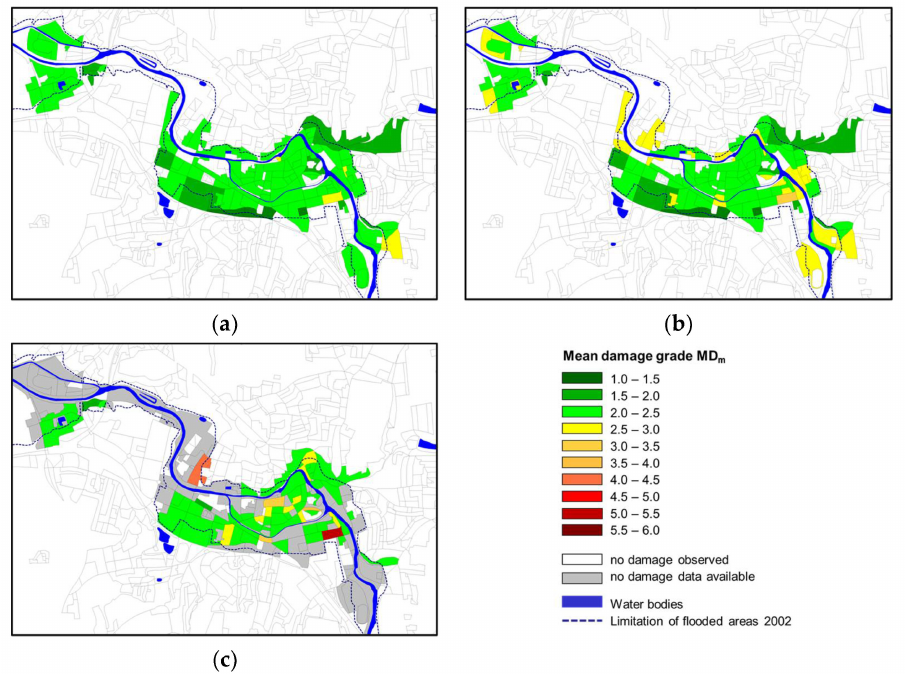
Figure 12. Comparison of the calculated mean damage grades ( MD m,calc ) in the land-use areas and the observed damage ( MD m,obs ) in the Döbeln investigation area: ( a ) calculated mean damage grades ( MD m,calc ), Level I; ( b ) calculated mean damage grades ( MD m,calc ), Level II; ( c ) observed mean damage grades ( MD m,obs